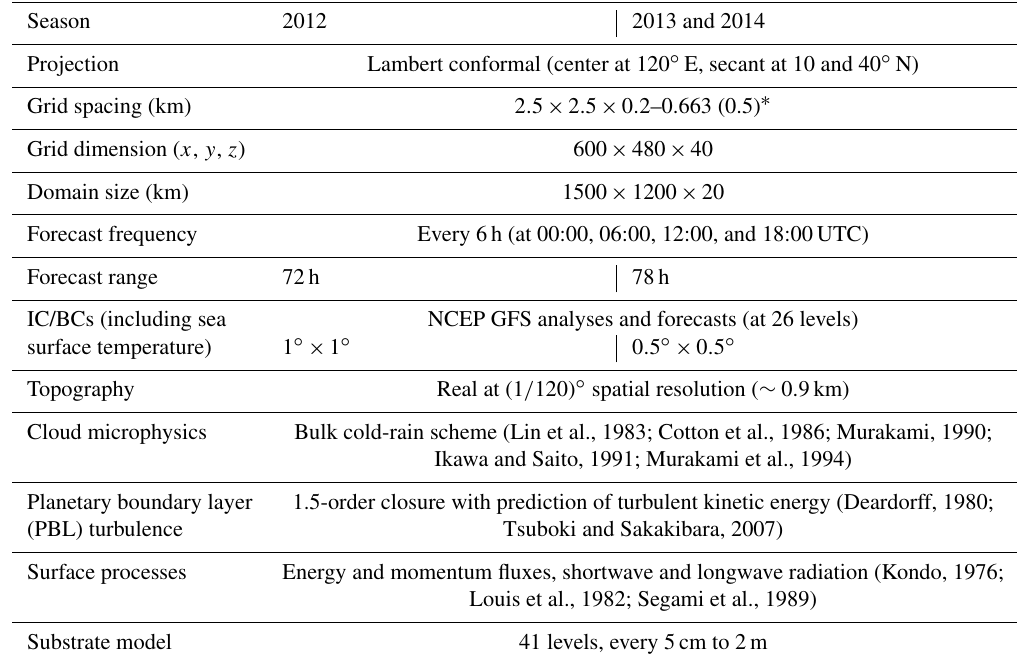
Table 1. The basic configuration, initial/boundary conditions (IC/BCs), and physical packages of the 2.5km CReSS used for real-time operation in 2012–2014. ∗ The vertical grid spacing of CReSS is stretched (smallest at bottom), and the averaged spacing is given in the